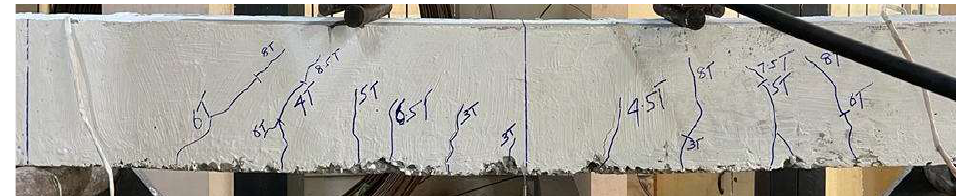
Figure 8. Conventional Concrete Beam.